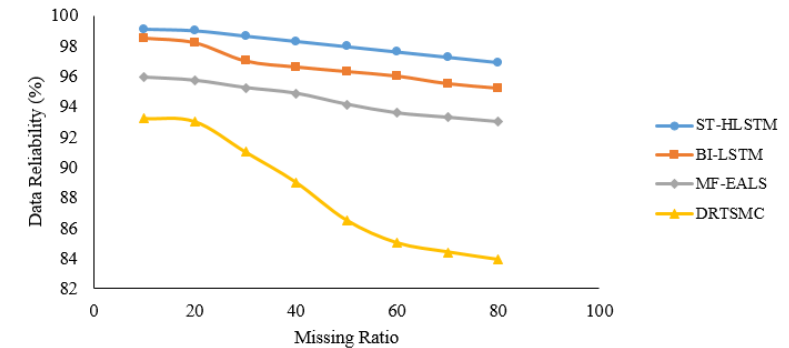
Figure 8. Reliability of Node21.